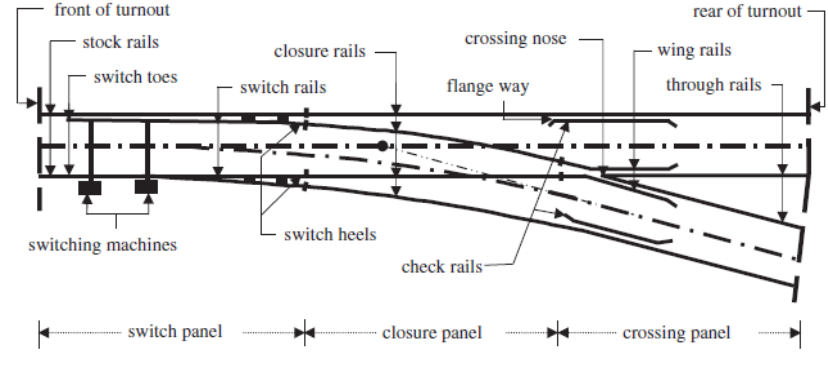
Figure 1. Components of a turnout [5].